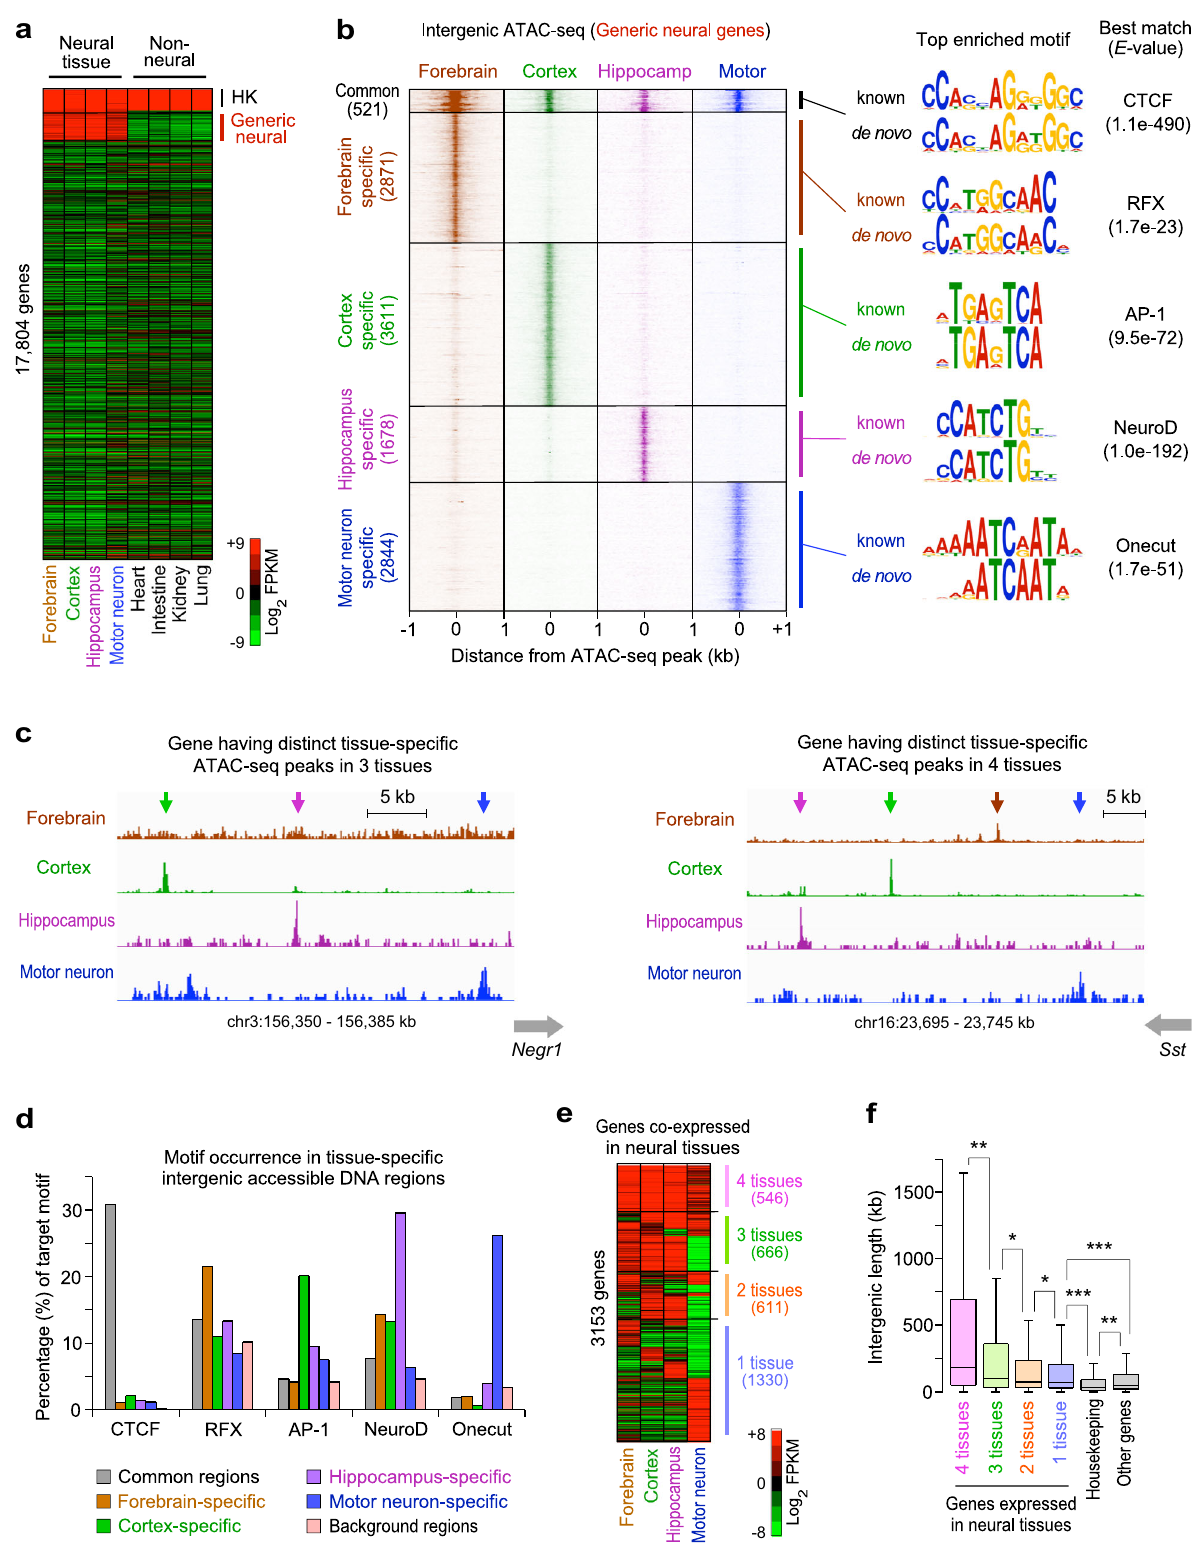
associated with an insulator or a topologically associated domain (TAD) boundary in the extended intergenic regions in neural and non-neural tissues 52,53 . We also found that the ATAC-seq peaks speci fi c in each tissue were enriched with H3K27ac in a tissue- speci fi c manner (Supplementary Fig. 8b). Together, our results indicate that the generic neural genes have a large number